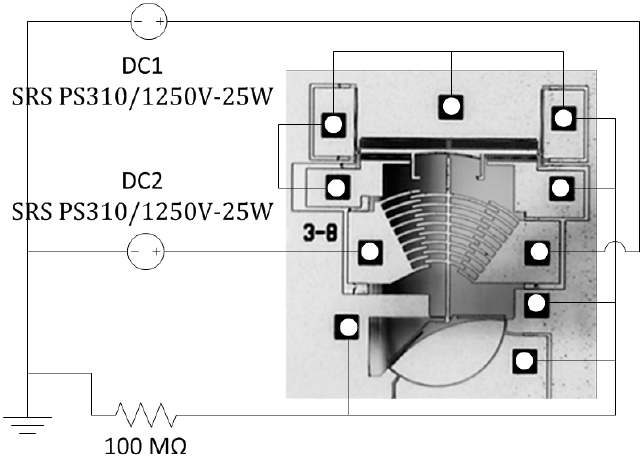
Figure 4. Test setup for the rotational actuation of the platform.